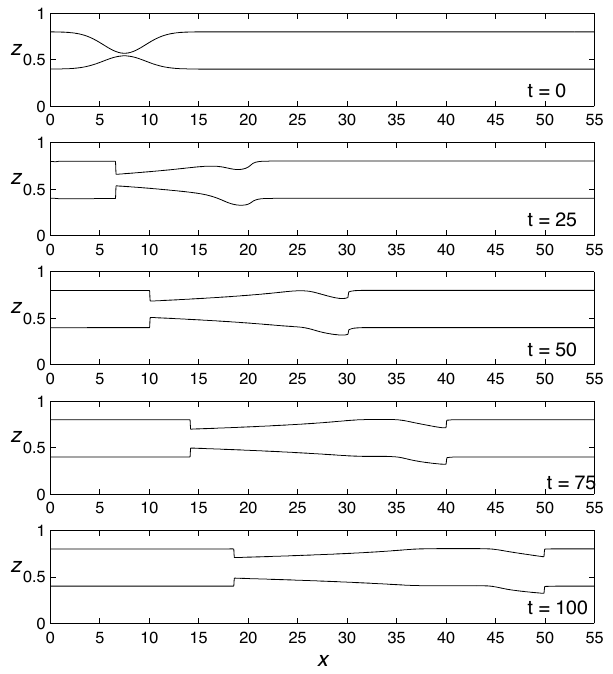
Fig. 12. (a) Speed of propagation of points on each interface, c , at t = 75 from Fig. 11. The lower (upper) interface is indicated by the solid (dashed) line. (b) Close-up of the interface positions from the numerical solution in Fig. 3 at t = 100 (blue solid lines) and the prediction from assuming simple wave behavior from Eq. (30) with c(ξ) from (a) (red dashed lines).